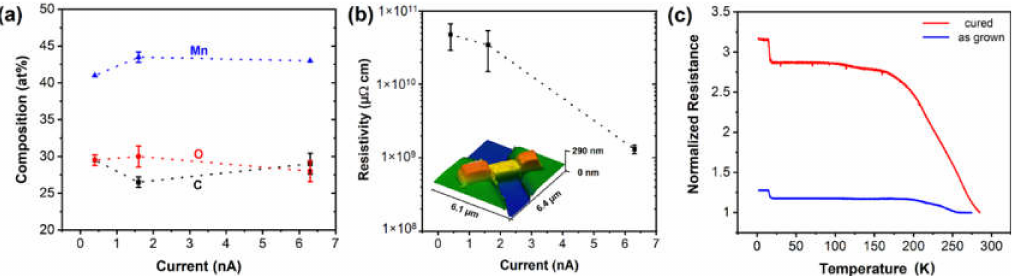
Figure 6. ( a ) EDX analyses show the composition of FEBID materials deposited at a 5 kV beam voltage and in response to the electron current in the range of 0.4–6.3 nA. ( b ) Electrical resistivity of the Mn-based FEBID material prepared at 0.4–6.3 nA and 5 kV. The values were derived from the resistance measurements of as-prepared material in the SEM by using the two-terminal device geometry and their geometrical factors determined by AFM. ( c ) Temperature-dependent electrical resistance evolution of two-terminal devices prepared at beam parameters of 6.3 nA and 5 kV and curing at 6.3 nA (1000 C/ µ m 2